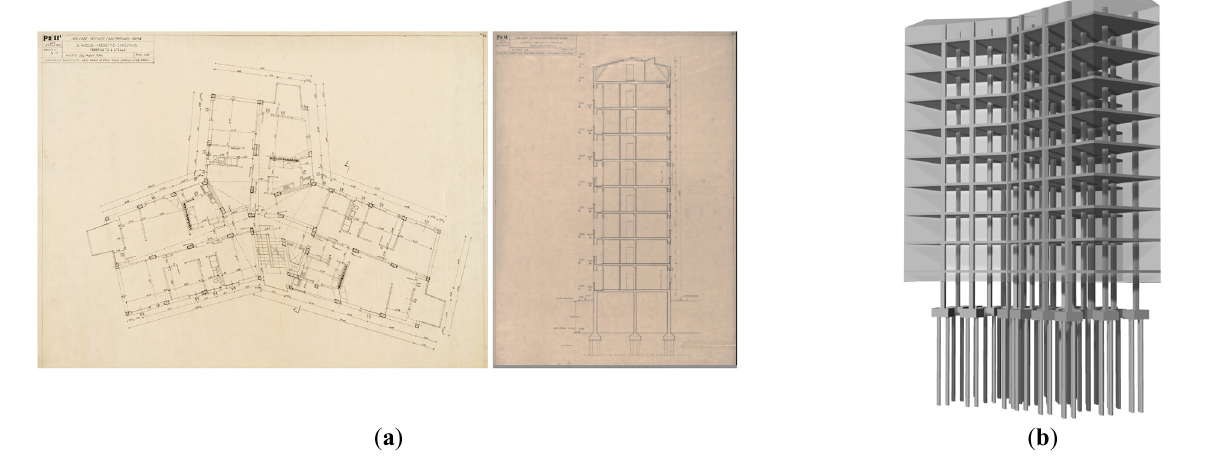
Figure 6. ( a ) Original design drawings of a Valco San Paolo INA-CASA housing district (1949–1952): M. De Renzi, star-shaped plan tower, plan of the first floor and section AA, 27 June 1950, 1:50 (courtesy of Accademia Nazionale di San Luca); ( b ) 3D model of the structure of the Tower n. 1.